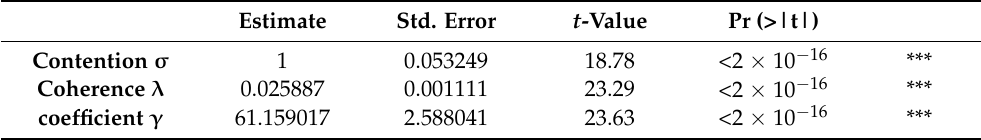
Table 5. USL Coefficients; Contention, Coherence modeled values.